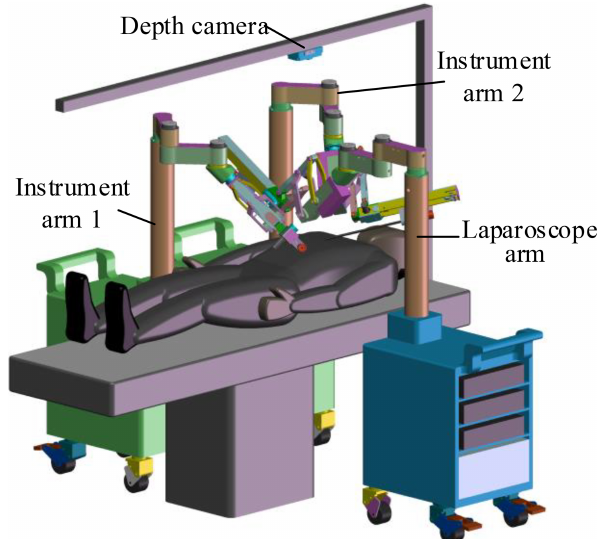
Figure 2. The MIS robotic system.